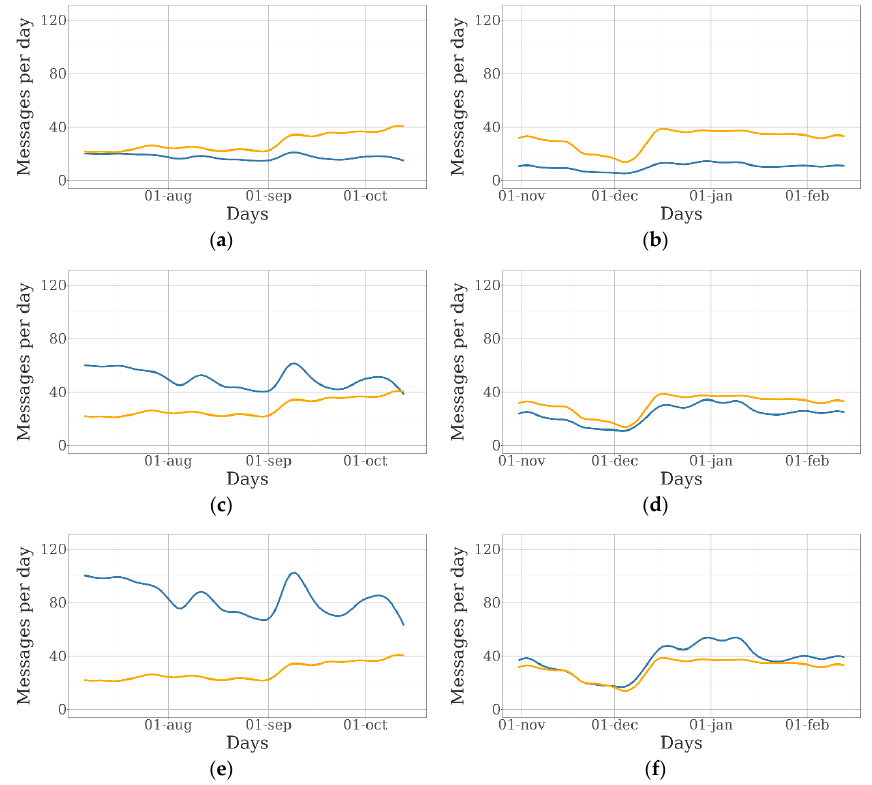
Figure 4. Evolution of the number of messages received daily from GPS collars (orange lines) and BLE tags (blue lines) over the experiment: ( a ) messages from the sheep farm with five collars and 25 tags; ( b ) messages from the beef cattle farm with five collars and 25 tags; ( c ) messages from the sheep farm with 15 collars and 25 tags; ( d ) messages from the beef cattle farm with 15 collars and 25 tags; ( e ) messages from the beef cattle farm with 25 collars and 25 tags; and ( f ) messages from the beef cattle farm with 15 collars and 25